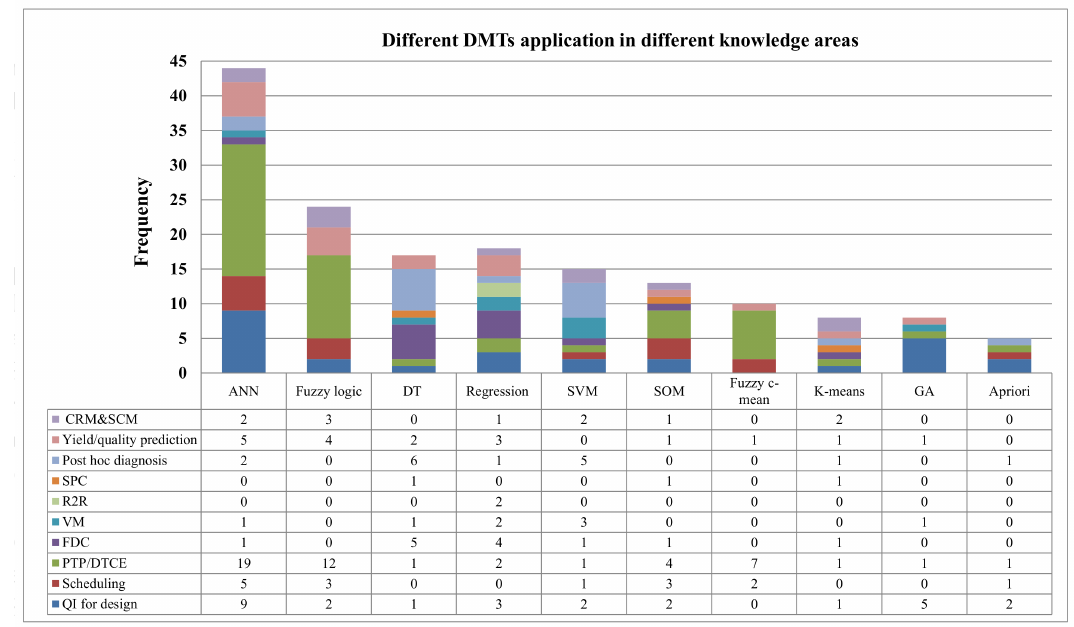
Figure 8. The different DMTs application in different knowledge